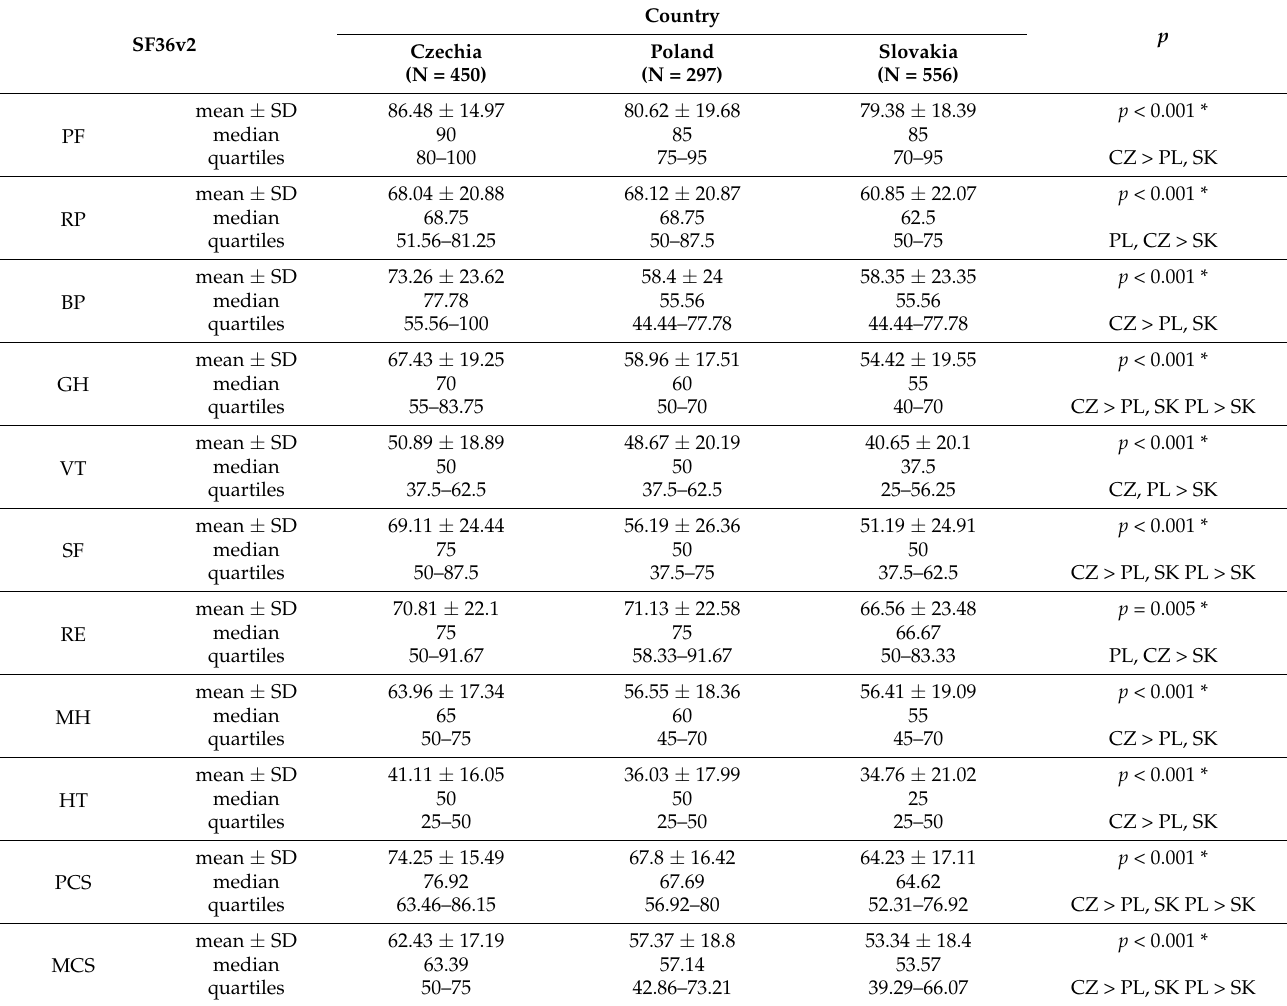
Table 2. A comparison of the quality of life of nurses from the Czech Republic, Poland, and Slovakia.